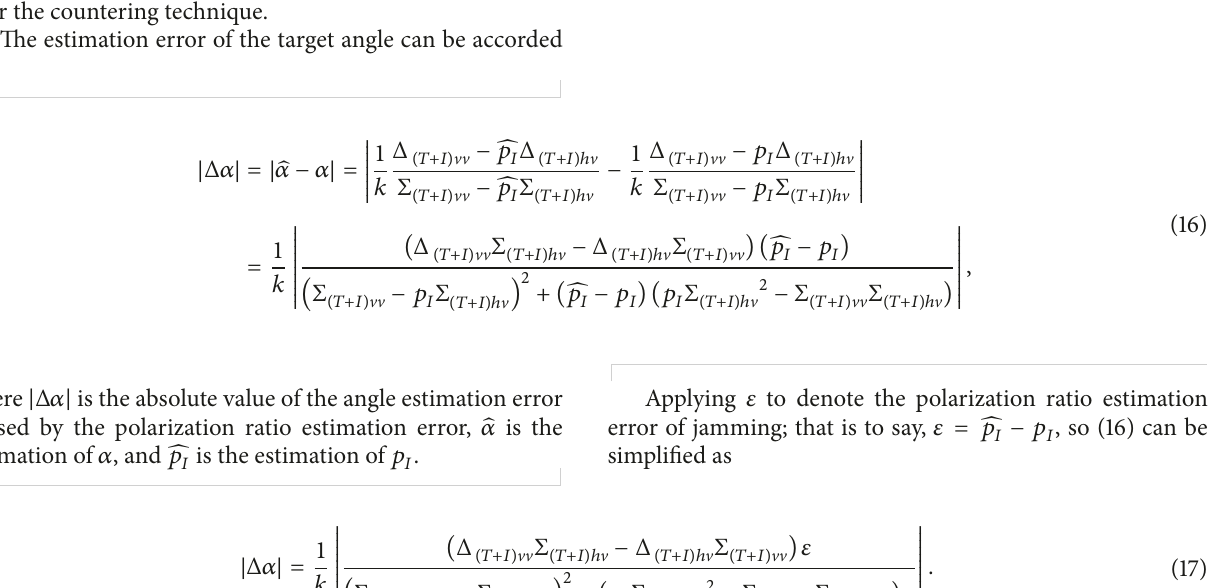
Figure 2: Procedure of adaptive processing